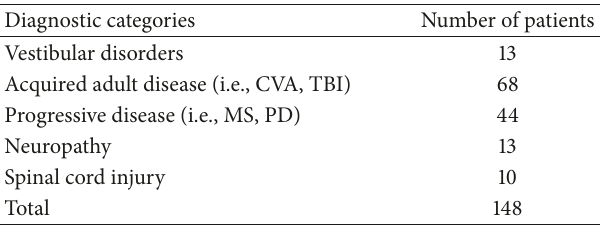
Table 3: Participant diagnostic